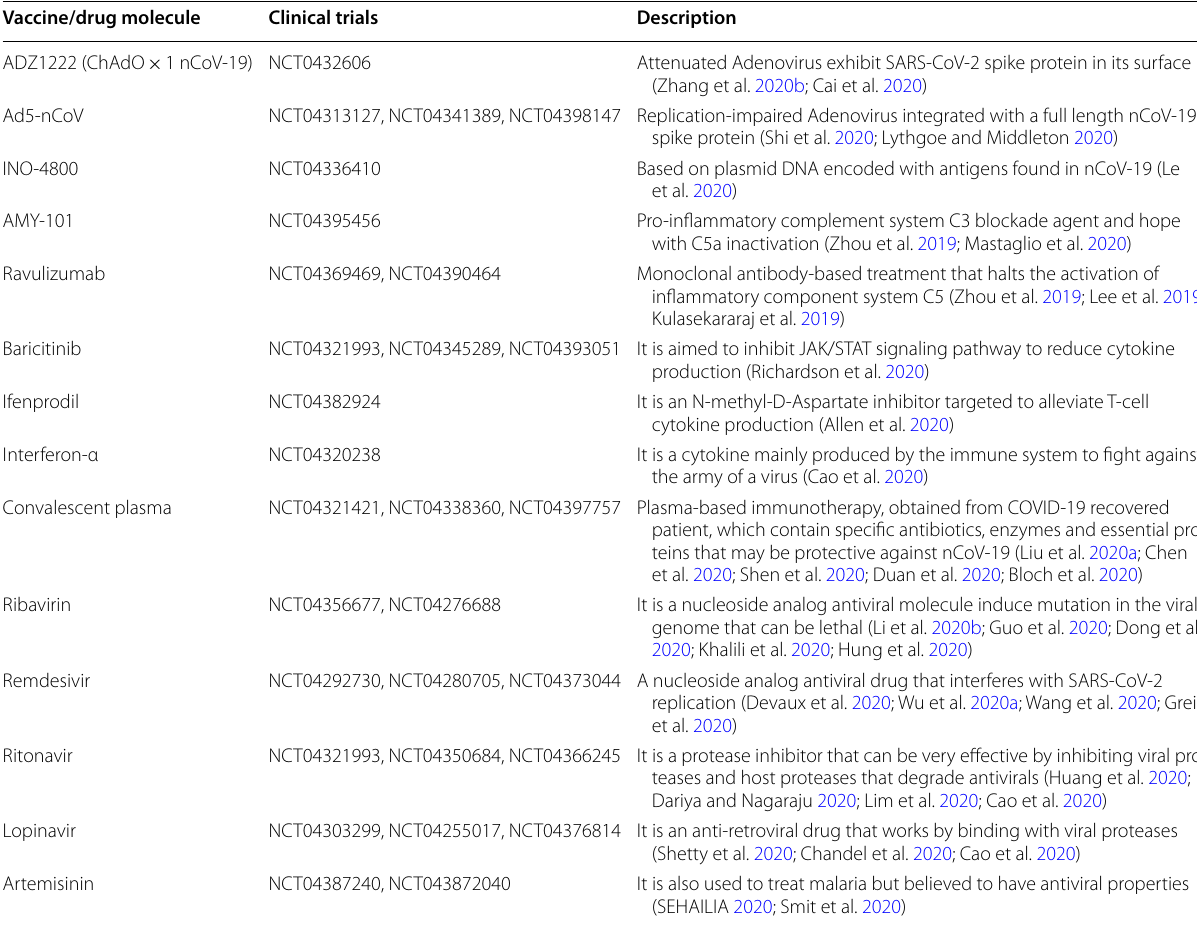
Table 1 Illustrate a few potential treatments for COVID-19 approved for human clinical trials Vaccine/drug